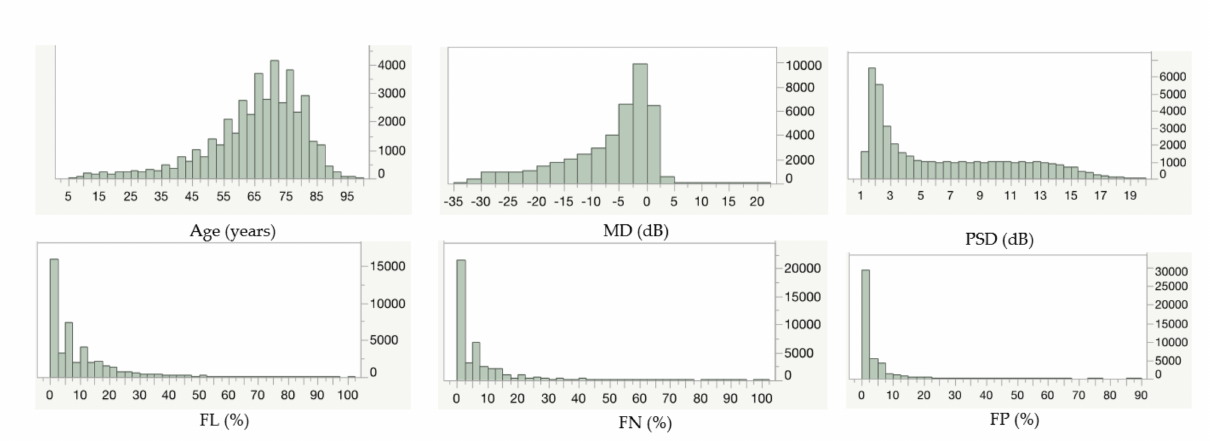
Figure 1. Distribution of the parameters. MD, mean deviation; PSD, pattern standard deviation; dB, decibel; FL, fixation loss; FN, false negative; FP, false positive.